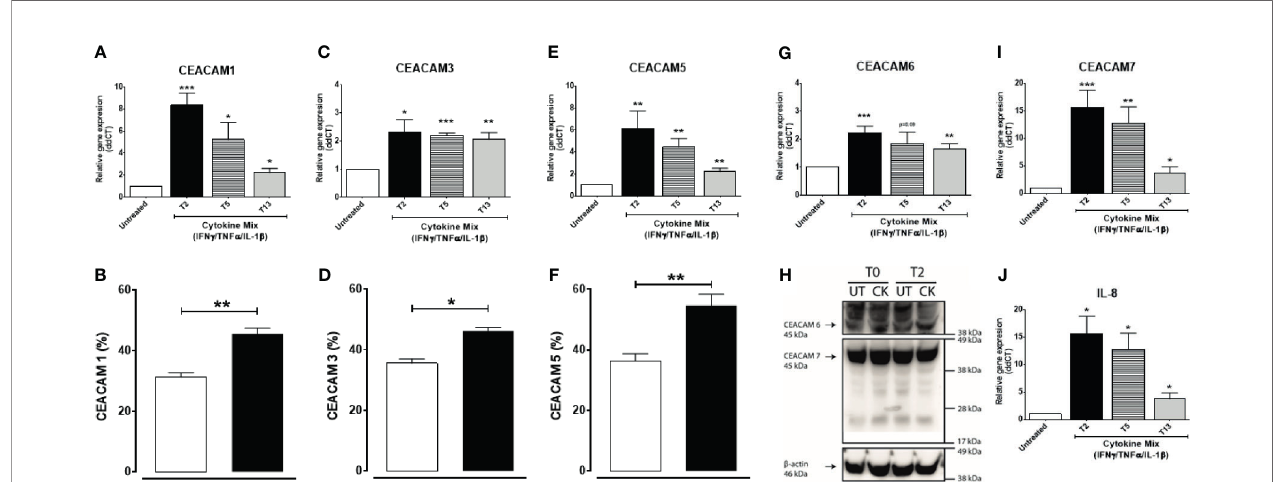
FIGURE 5 | C2BBe1 cells cultured for 3 h with the pro-in fl ammatory cytokine cocktail containing recombinant human (rh) TNF- a (20 ng/ml), rh IFN- g (10 ng/ml), rh IL-1 b (10 ng/ml), and untreated. After the 3 h co-culture (T0), cells are washed followed by further culture in full culture media for 2 (T2), 5 (T5), and 13 (T13) h. Samples are collected at T0, T2, T5, and T13 time points for analysis on gene and protein expression of (A, B) CEACAM1, (C, D) CEACAM3, (E, F) CEACAM5, (G, H) CEACAM6, (H, I) CEACAM7, and (J) IL-8 as determined by RT q-PCR, fl ow cytometry (CEACAM1, -3, -5), WB (CEACAM6 and 7). For gene expression analysis, graphs are representative of three to fi ve independent experiments with pooled triplicate samples and RT-qPCR assay performed in duplicates. b -actin was used as a housekeeping gene, and results are expressed as fold change. For protein analysis with fl ow cytometry and WB, graphs are representative of two independent experiments with pooled duplicates/triplicates. In the fl ow cytometry graphs (B, D, F) white colums represent untreated samples and black columns represent cytokine cocktail treated samples collected at T5. A Student t-test was used to analyze gene and protein data. *P < 0.05, **P < 0.01, ***P < 0.001 when compared to untreated cells. UT, untreated; CK, cytokine cocktail treatment.